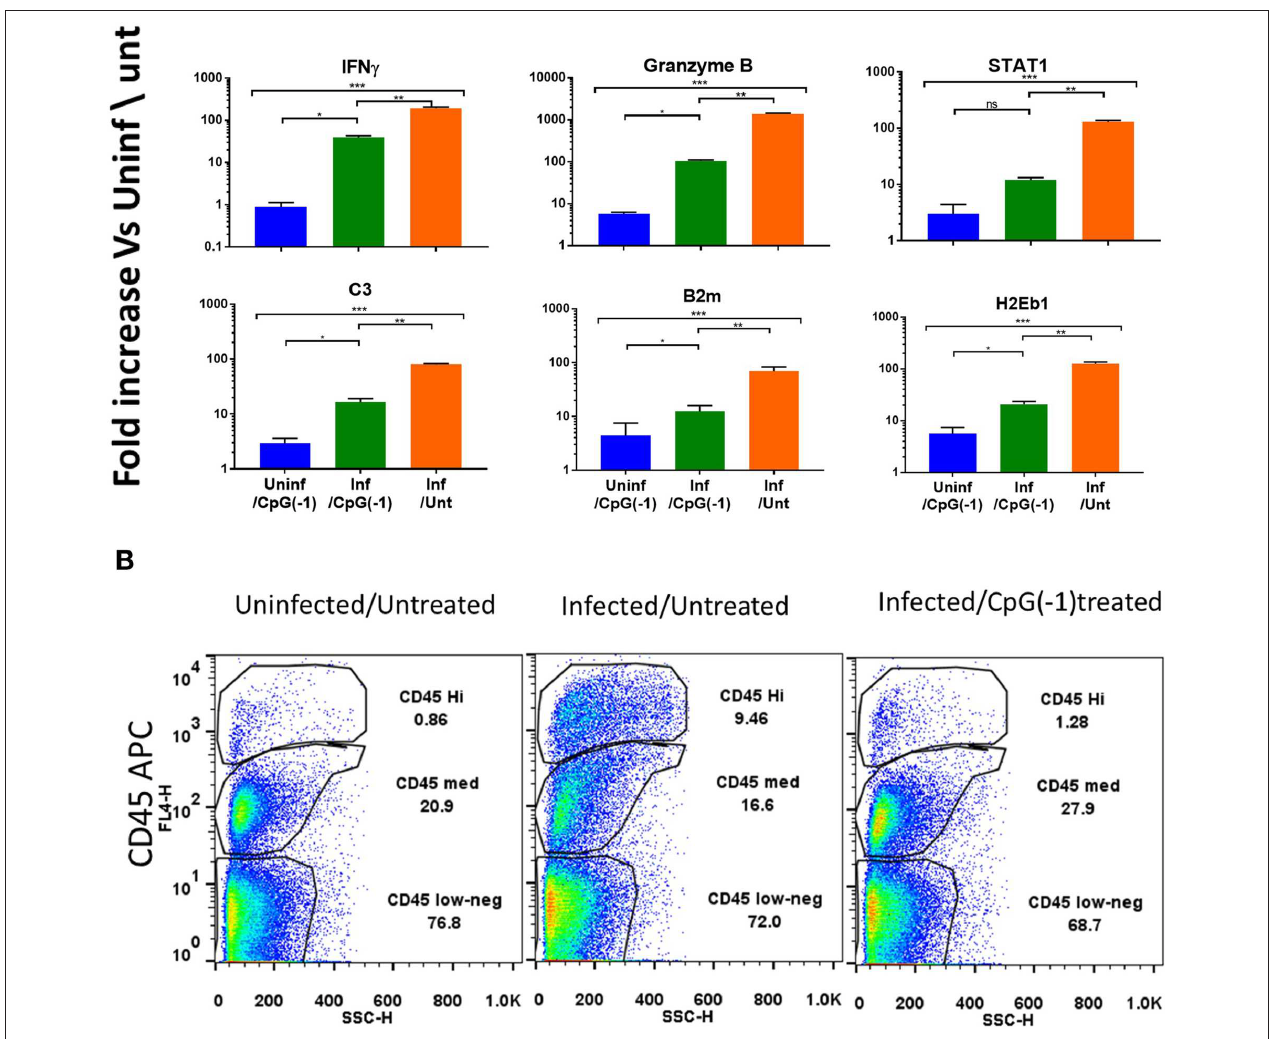
FIGURE 5 | CpG ODN reduces expression of inflammatory genes and infiltrating cells in the infected CNS: B6-WT mice were treated CpG ODN (50 µ g IP on P2) and infected with SINV (25 PFU SC) as above. Controls included age-matched untreated/uninfected and CpG ODN-treated/uninfected mice. Brain mRNA was collected from perfused animals at 6 dpi. (A) mRNA expression analyzed using Taqman Low Density Arrays and expressed as fold change over uninfected/untreated samples. (B) Cellular infiltration (CD45HI) as assessed by flow cytometry was performed at